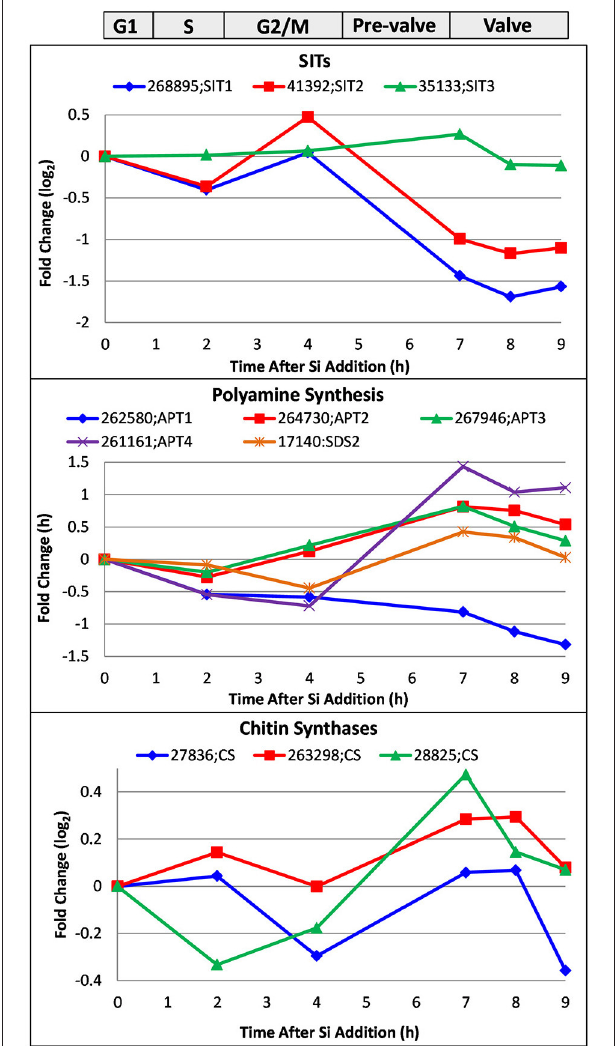
FIGURE 8 | Whole genome microarray analysis of transcript level changes of proteins peripherally involved in T. pseudonana silicification. Log base 2 fold changes relative to 0h are plotted. Transcripts were measured in a synchronized culture where cell cycle progression began after silicic addition to a silicon-starved culture. Approximate timing of different cell cycle stages is shown at top. Data are from Shrestha et al.